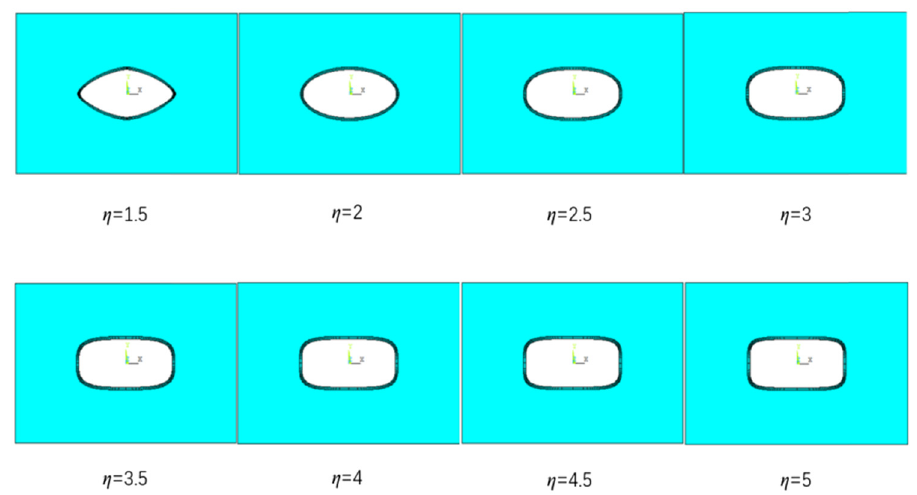
Figure 8: Hyper - ellipse cutout models with di ff erent